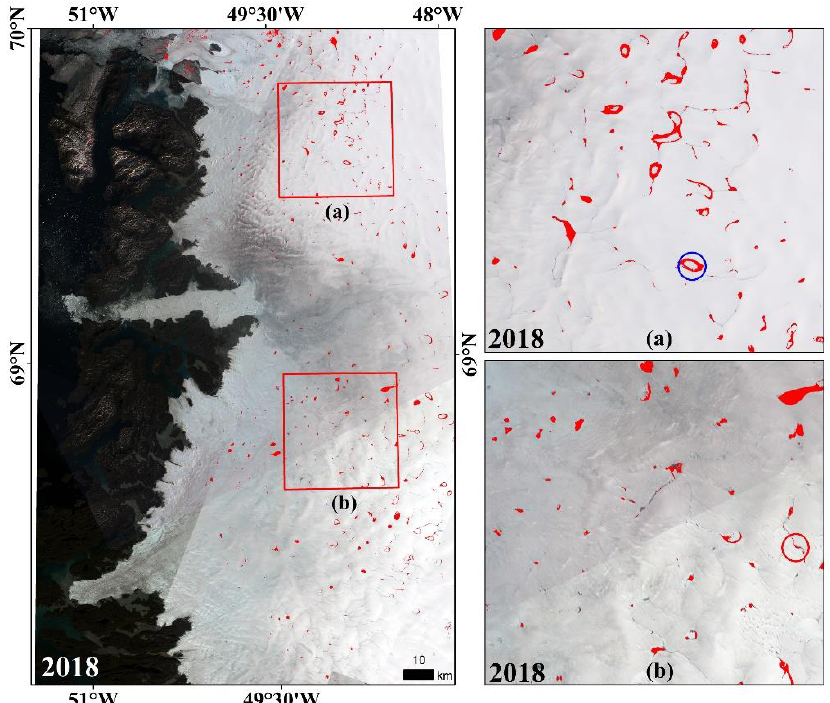
Figure 9. Water identification results in 2018. ( a , b ) Two detailed subregions from the subfigure on the left. Red stands for identified water. The blue circle shows floating ice in the SGL as a hollow ring and the red circle shows a river as a narrow segment.